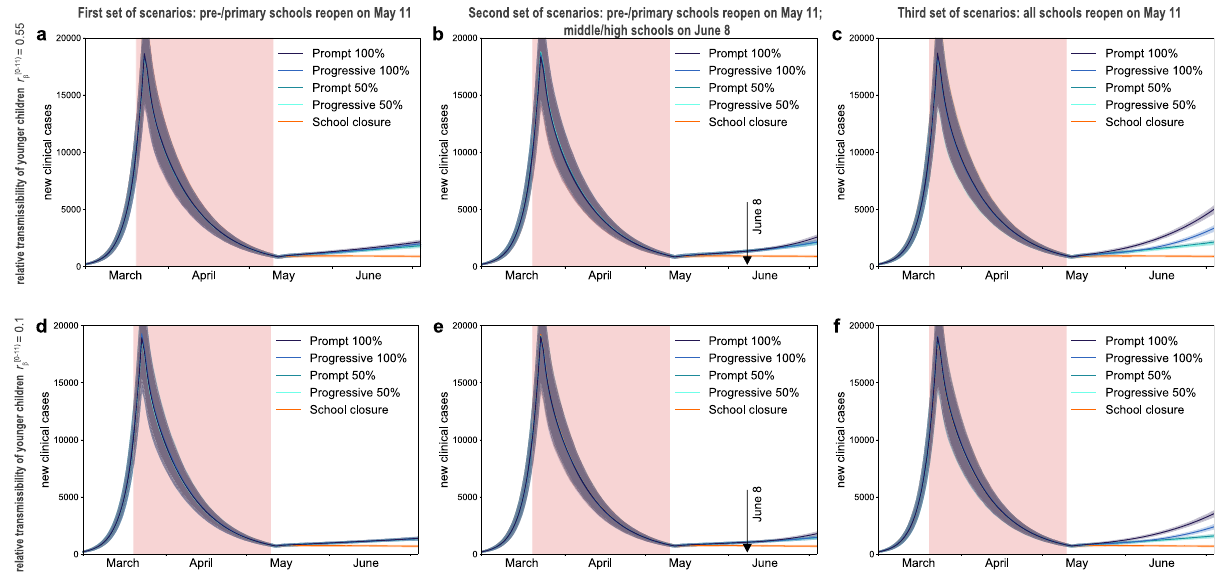
Fig. 3 Simulated epidemic activity in scenarios with reopening of schools. a – c Simulated daily number of new clinical cases assuming that only pre- schools and primary schools are reopened on May 11 through 4 different protocols ( fi rst set of scenarios, panel a ), additionally considering the reopening of middle and high schools on June 8 (second set of scenarios, panel b ), or assuming that all school levels reopen on May 11 (third set of scenarios, panel c ). Four protocols ( Progressive (100%, 50%), Prompt (100%, 50%) ) are compared to the school closure scenario. Curves and shaded areas correspond to median and 95% probability ranges, obtained from n = 500 independent stochastic runs. Results are obtained for a relative transmissibility of younger children r ½ 0 (cid:2) 11 Þ β